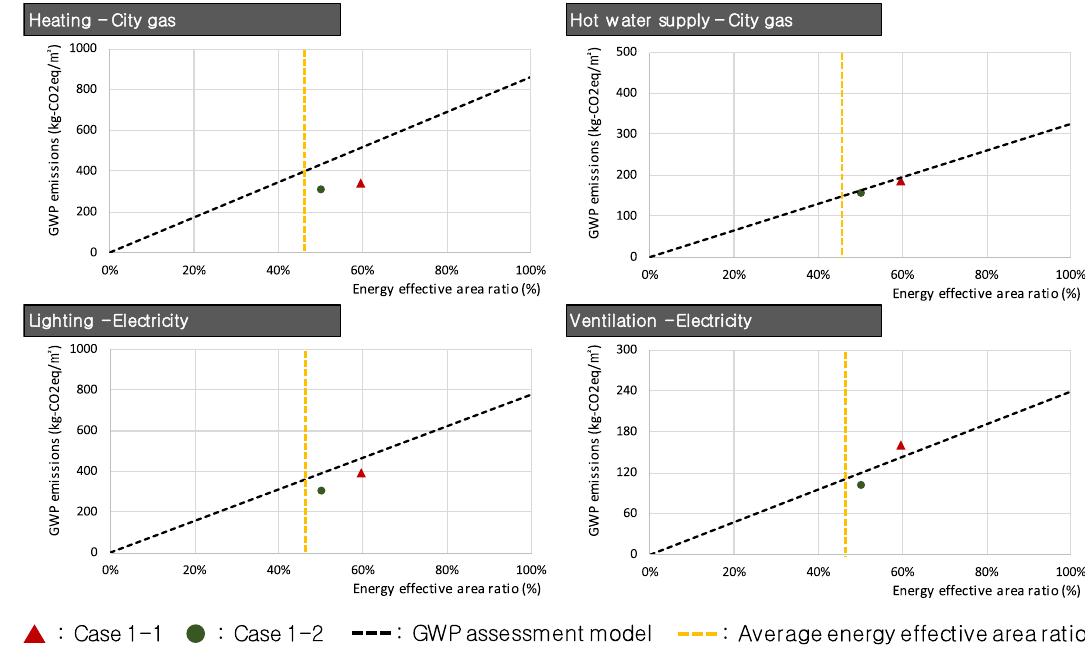
Figure 5. Case study results of Group #1.